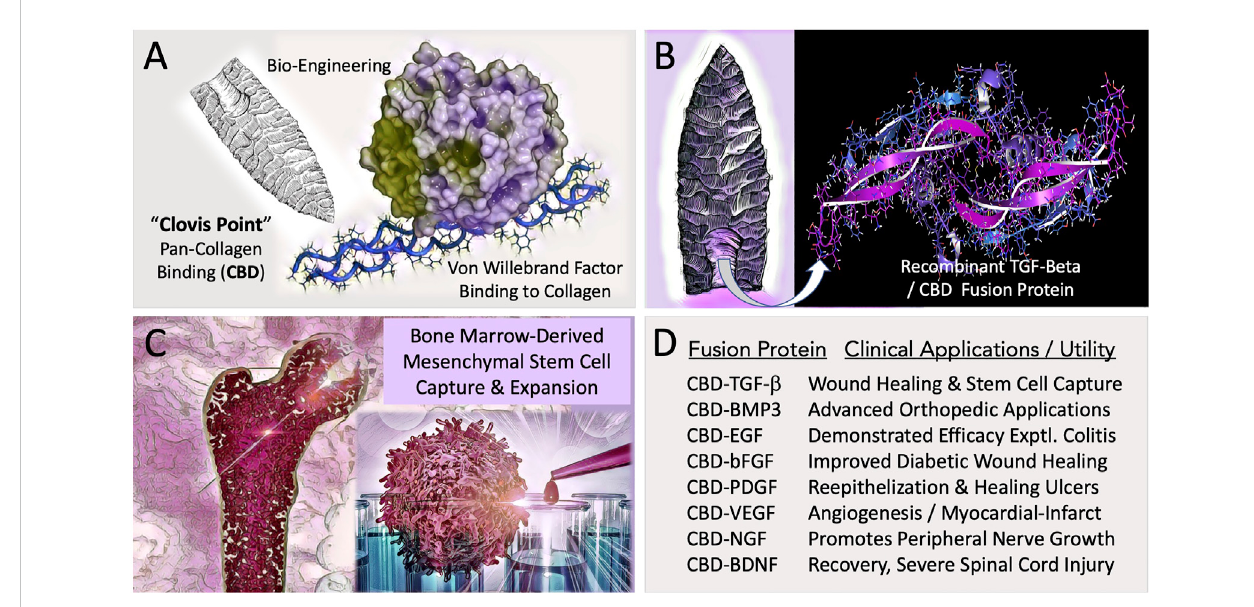
FIGURE 1 Engineering and Potential Clinical Utility of Collagen Binding (CBD) Growth Factors. (A) Concept of “ hafting ” a Pan-Collagen Binding Domain (CBD) — a molecular “ Clovis Point ”— by adaptive bio-engineering of vWF. (B) Chimeric growth factor protein expression in microorganisms, followed by puri fi cation andrenaturationoftherecombinantfusionpolypeptides,(e.g.,CBD-BMP3)provided theabundant bioactivematerialsneededfor preclinical studies and translational research. (C) Graphic fi gure depicts the capture, expansion, conditioning, and differentiation of bone-marrow derived pre- hematopoietic, pre-mesenchymal stem cells for cell- and gene-based therapies. (D) Examples of collagen-targeted growth factors, highlighting advances in the potential utility of the biotechnology platform in the form of preclinical